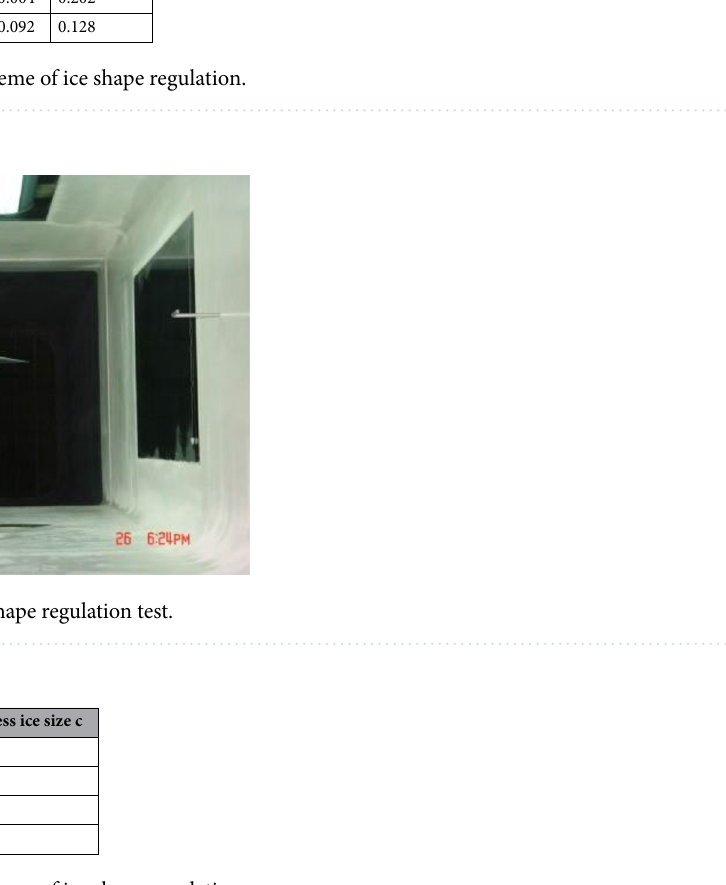
Table 2. Experimental scheme of ice shape